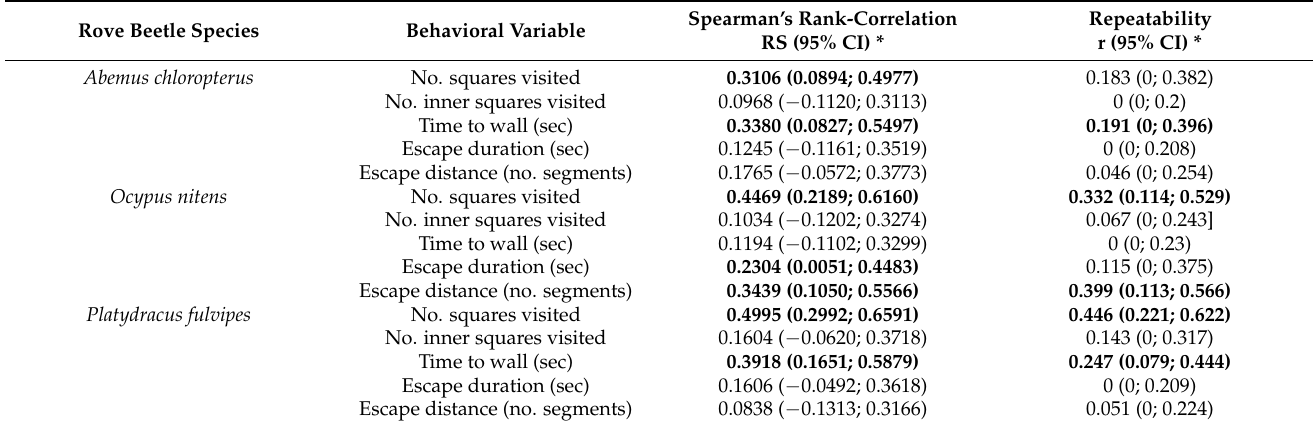
Table 2. Spearman rank-correlation (RS) and (adjusted) repeatability (r) for the behavioral measures of the two consecutive trials. Values in bold denote significant ( p < 0.05)